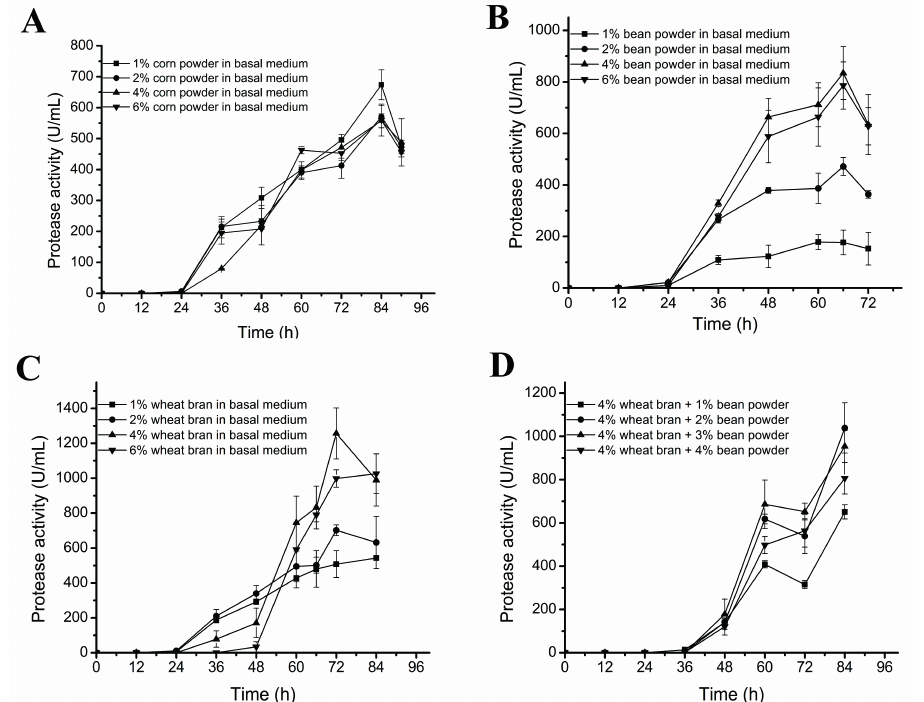
Figure 2. Effects of the contents of carbon source and nitrogen source in the medium on the protease production of D25. ( A ) Effect of corn powder content with 2% bean powder and 1% wheat bran in the medium; ( B ) Effect of bean powder content with 2% corn powder and 1% wheat bran in the medium; ( C ) Effect of wheat bran content with 2% corn powder and 2% bean powder in the medium; ( D ) Effect of bean powder content with 2% corn powder and 4% wheat bran in the medium. For ( A – C ), D25 was cultured at 15 °C and 200 rpm with a tested single factor being changed in the basal medium. For ( D ), D25 was cultured at 15 °C and 200 rpm with bean powder content being changed in a revised basal medium containing 4% wheat bran instead of 2% wheat bran. The graph shows data from triplicate treatments (mean ±